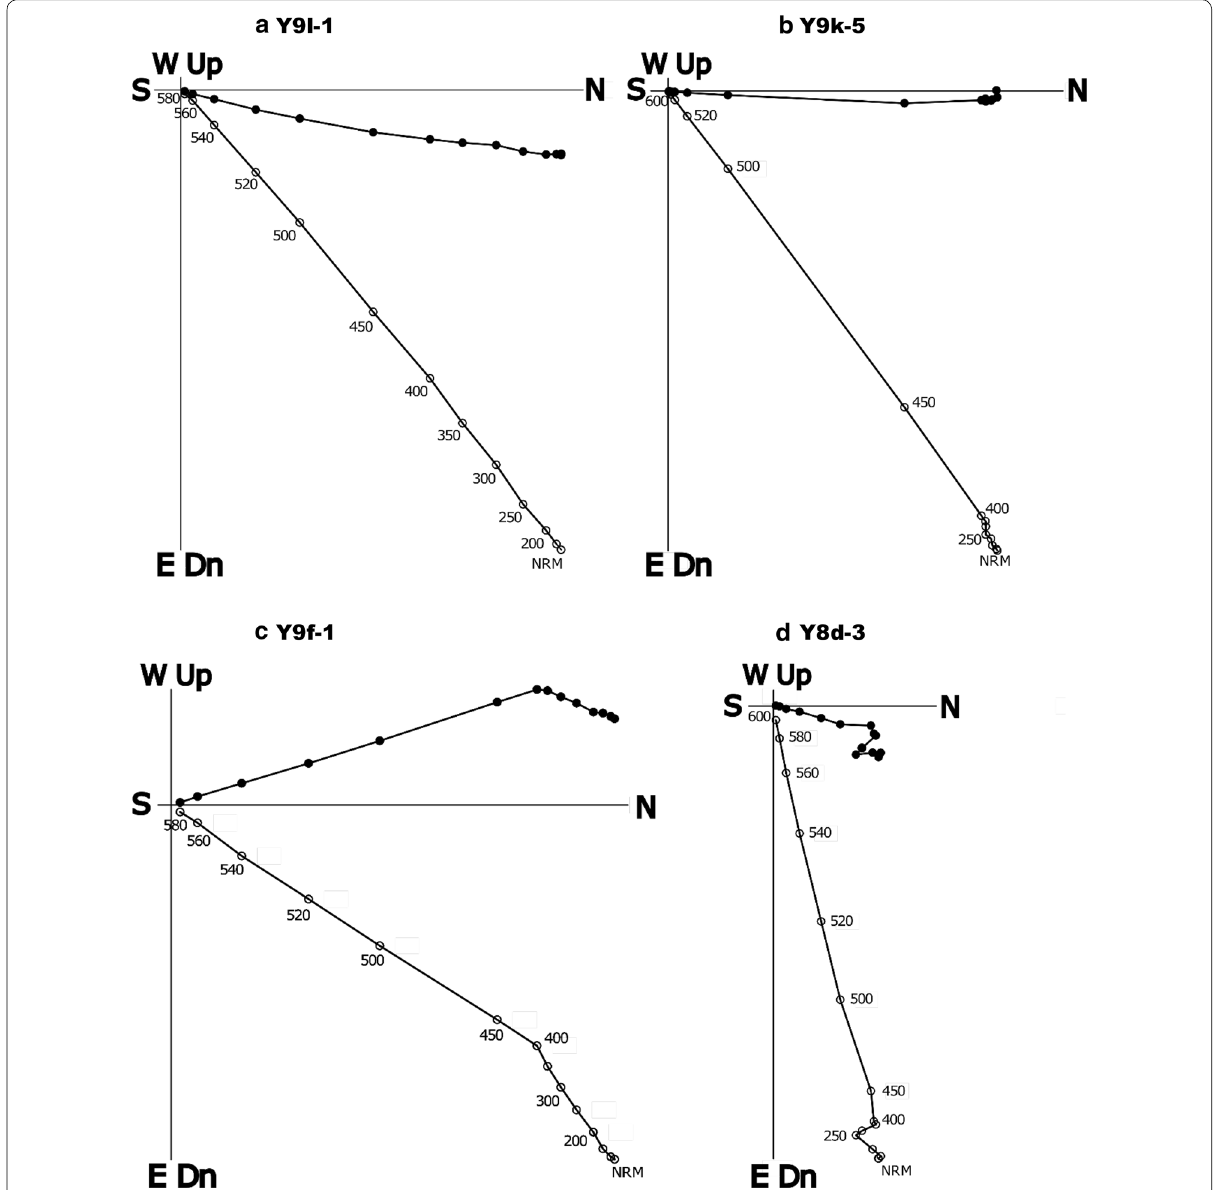
Fig. 3 Typical Zijderveld plots for PThD experiments. Solid and open circles, respectively, denote the horizontal and vertical projection. a One magnetic component with smooth decay to the origin. b Two magnetic components with a small low-temperature component. c Two magnetic components with a steady low-temperature component. d Multi-magnetic